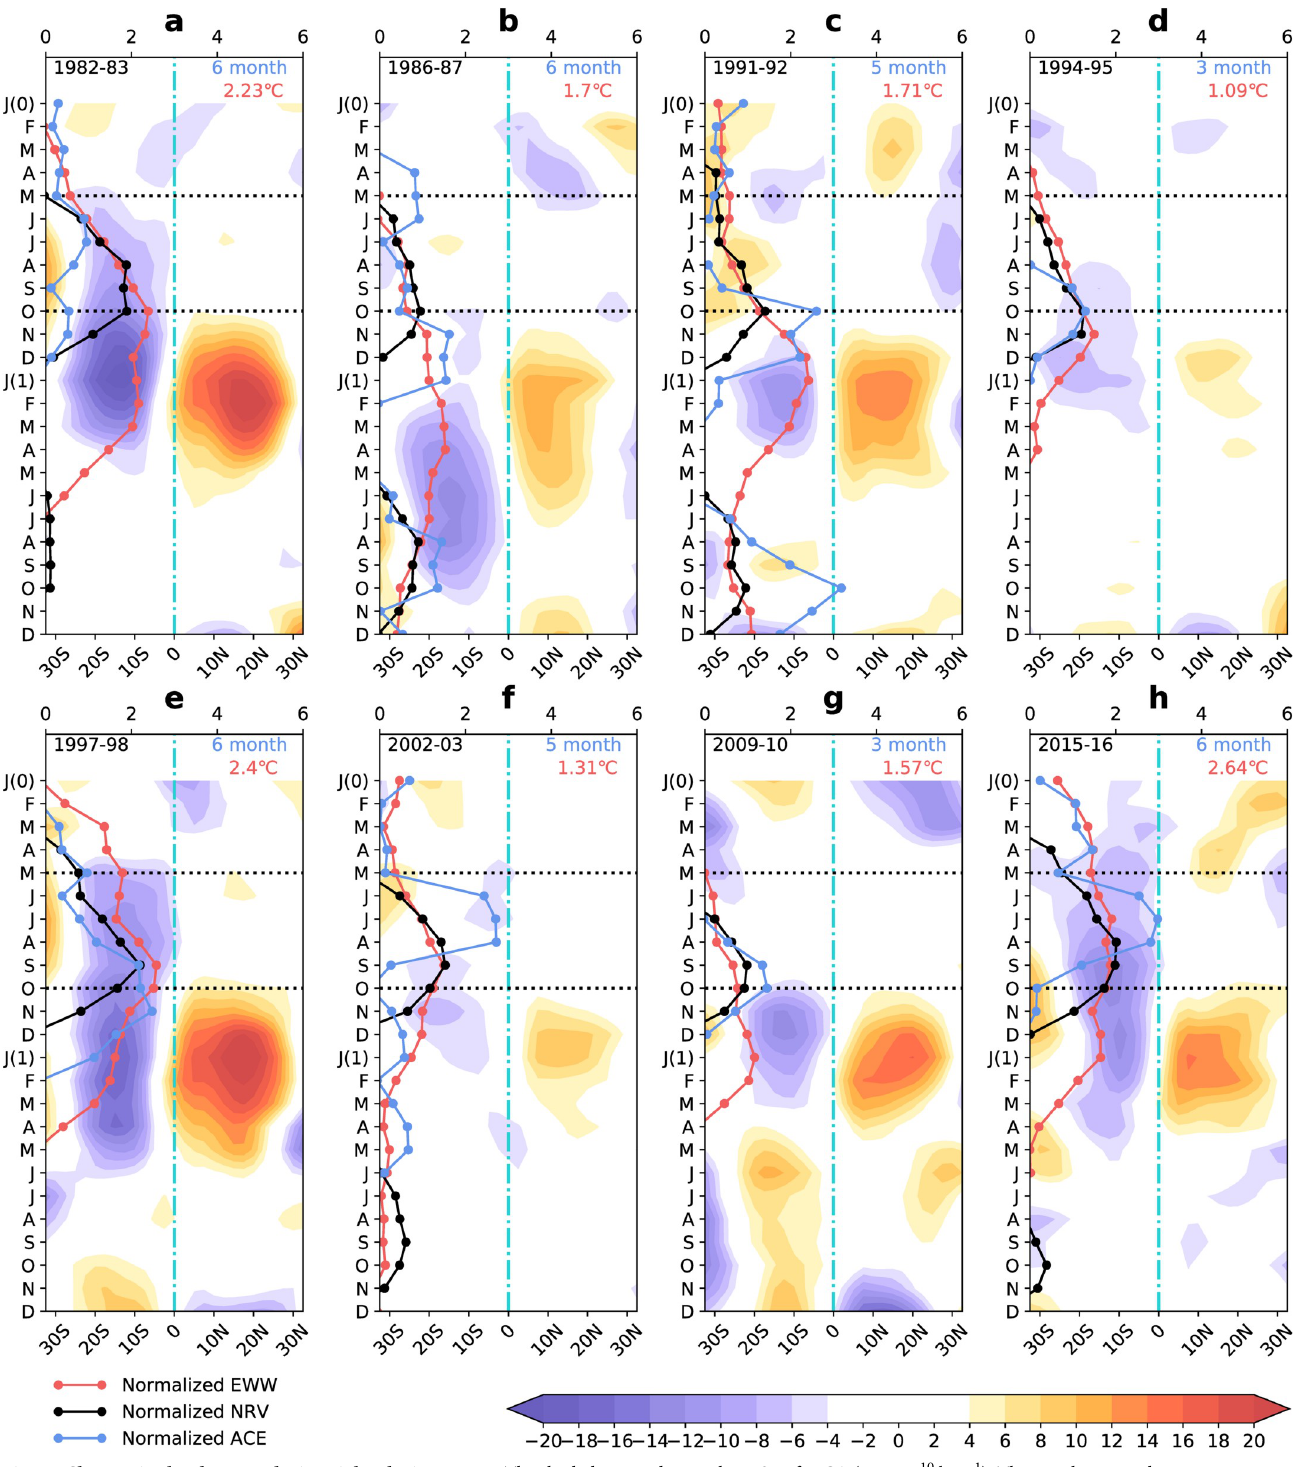
Fig 10. Changes in the elements during eight El Ni ñ o events. The shaded area indicates the MSF of MCA (unit: 10 10 kg s -1 ). The purple area indicates counter- clockwise movement and the red or yellow area indicates clockwise movement. The red line indicates the normalised EWW, the black line indicates the normalised NRV, and the blue line indicates the normalised ACE. The blue numbers in the upper right indicate the months when the ACE was positive from May to October during the developing year. The red numbers in the upper right are the maximum that the ONI can reach during El Ni ñ o years. The black numbers in the upper left are each El Ni ñ o year. J (0)-D indicates January to December during El Ni ñ o developing years. J (1)-D indicates January to December during El Ni ñ o decaying years. The black dotted line indicates May to October. The blue dotted line indicates 0˚. https://doi.org/10.1371/journal.pone.0259599.g010 PLOS ONE | https://doi.org/10.1371/journal.pone.0259599 November5,